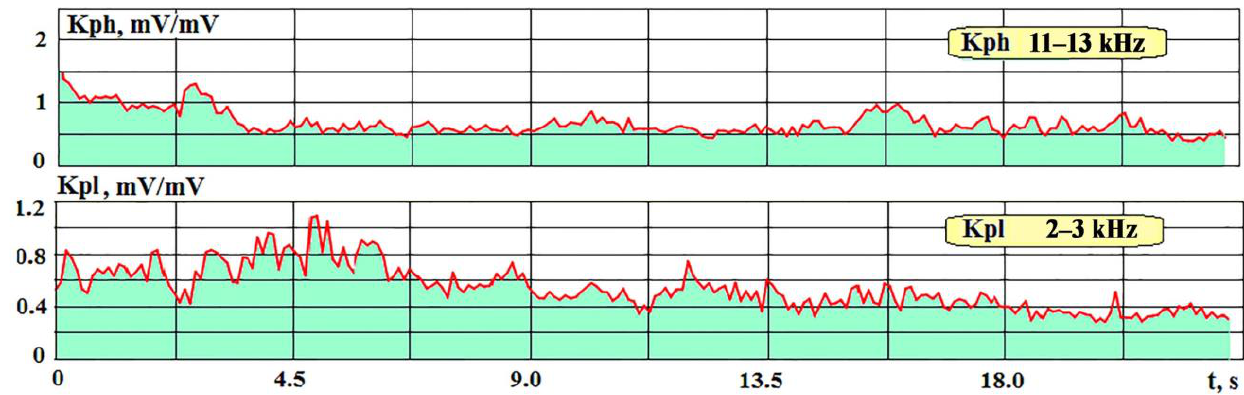
Figure 13. Changes in transmission coefficients at high frequencies (upper graph) and low frequencies (lower graph) from the moment of embedding to the break of the wire electrode when resuming the WEDM of the HS123 hard alloy after the electrode break is eliminated.